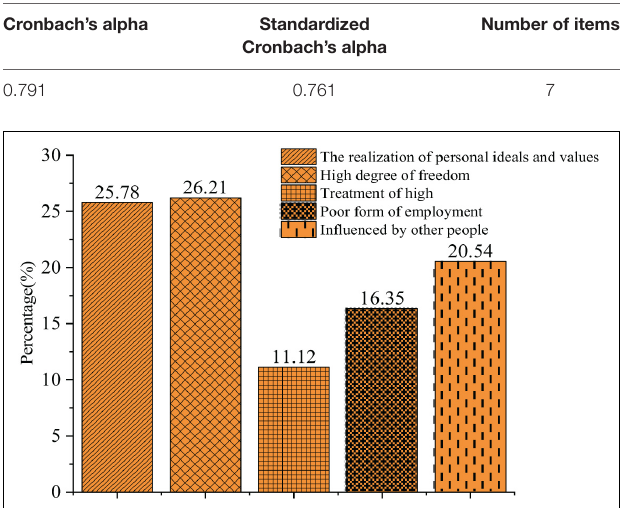
FIGURE 1 | Factors influencing the entrepreneurial